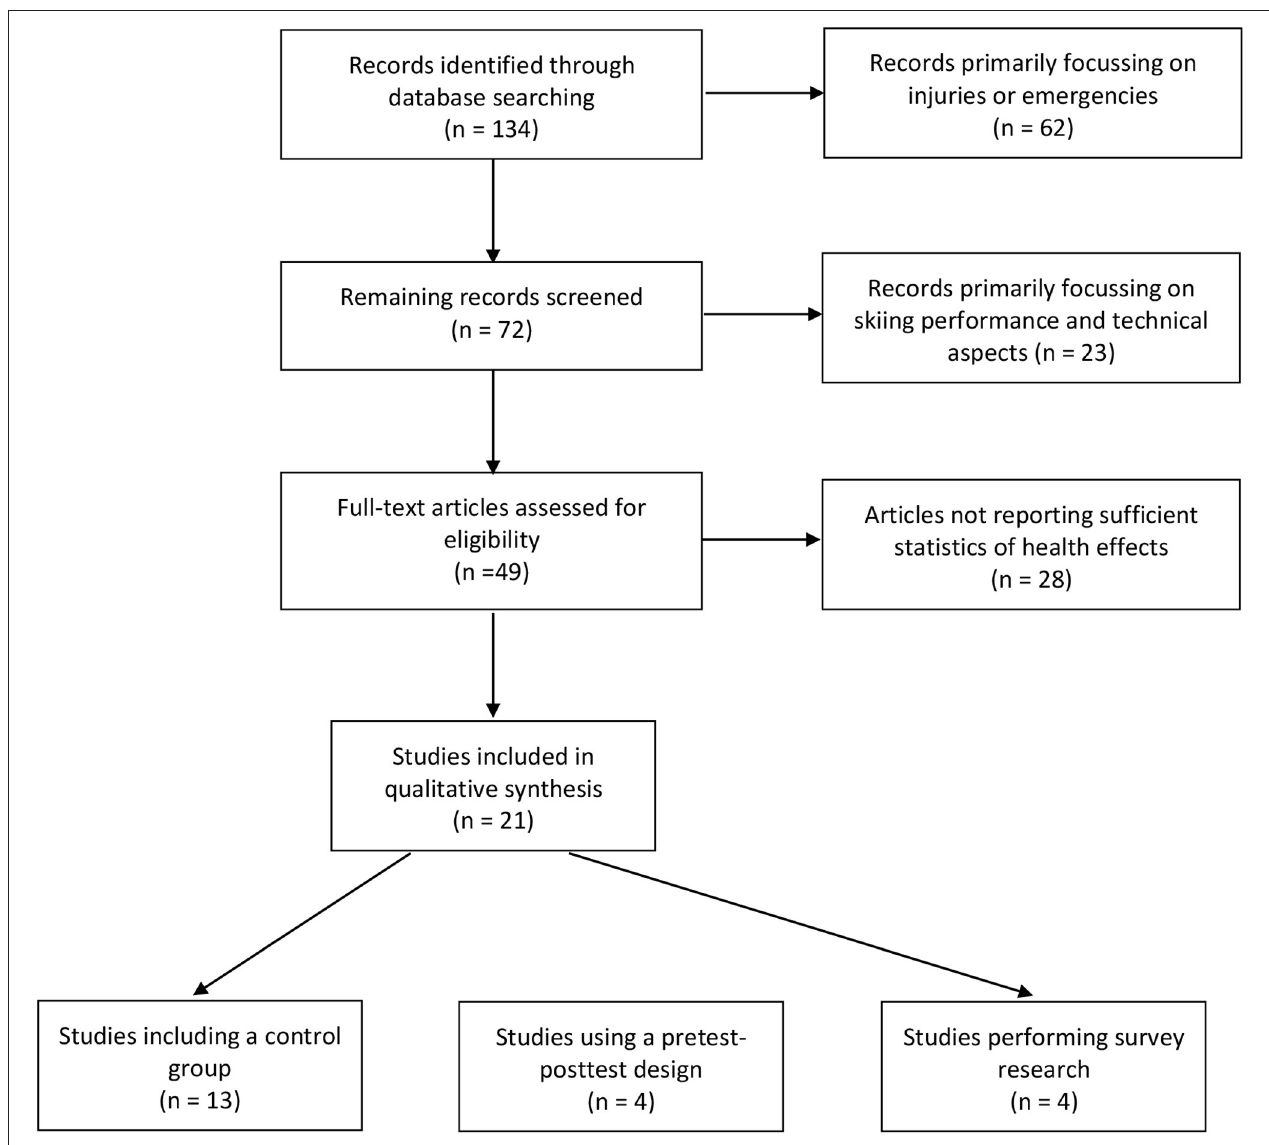
FIGURE 1 | Flow diagram for search and selection of the included